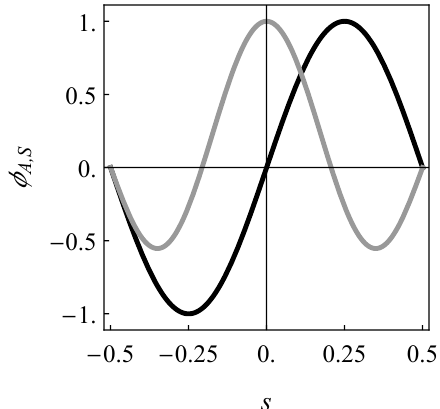
Figure 3. Natural modes of the undamped model: First antisymmetric modes φ A ( s ) (black solid line); Second symmetric mode φ S ( s ) (gray solid line).